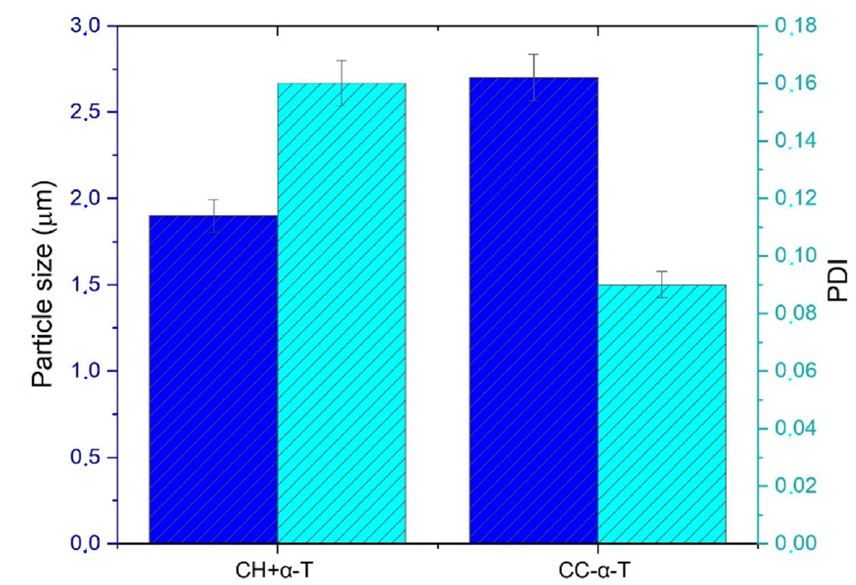
Figure 5. Particle size and PDI of particles produced by membrane emulsification (ME).